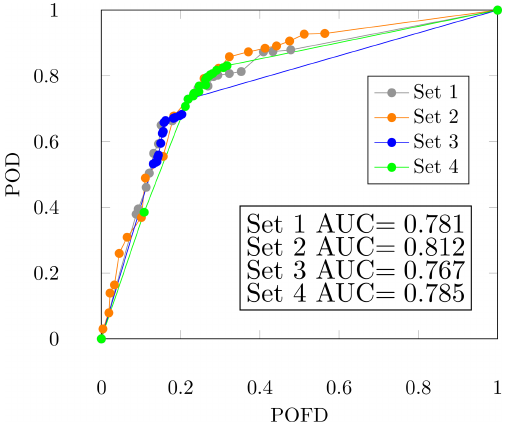
Figure 5. ROC curves for the set of thresholds reported in Table 9.